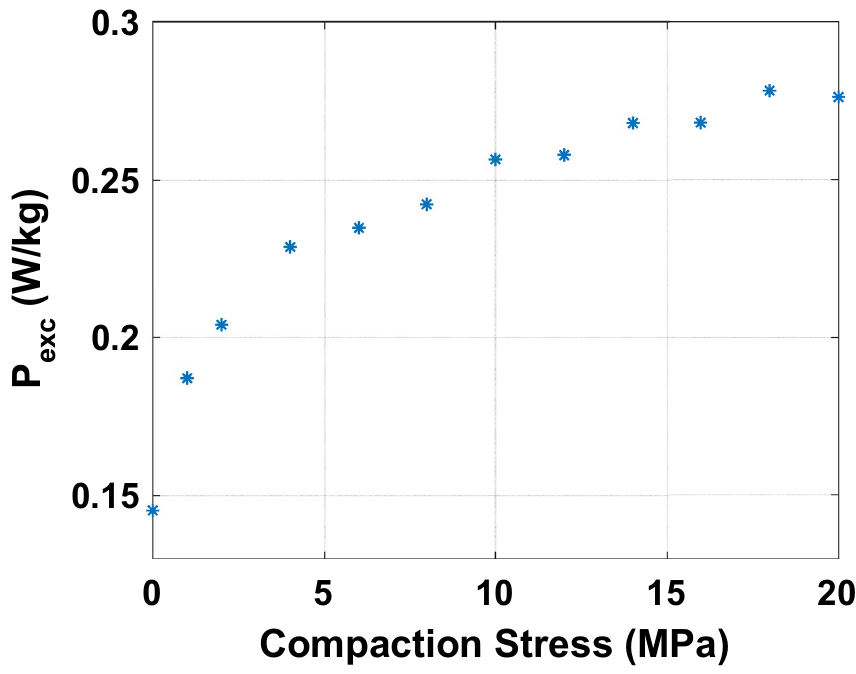
Figure 21. Excess loss evolution as a function of compaction stress for 1 T at 50 Hz - Homogeneous case.